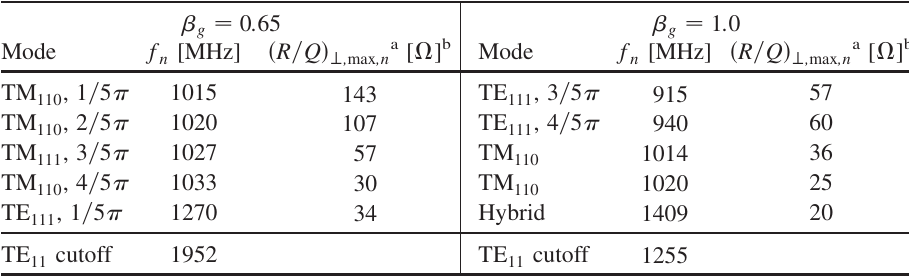
TABLE IV. Dipole modes with the highest ð R=Q Þ ? ð (cid:1) Þ values found in the symmetrical SPL cavity